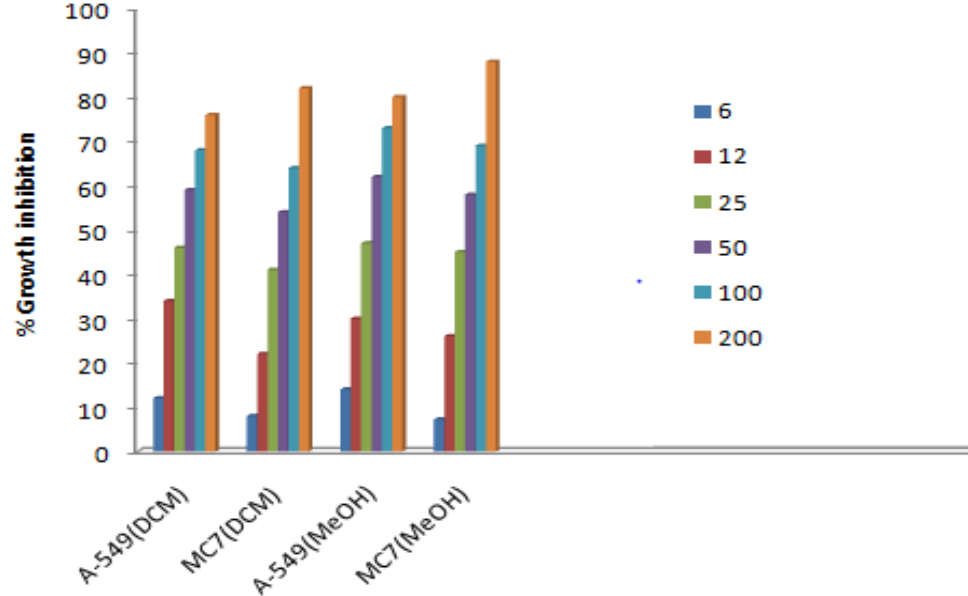
Figure 5. In vitro cancer activity of dicholoromethane and methanol extract of N. mexicana Zucc. against MC7 and A-549.